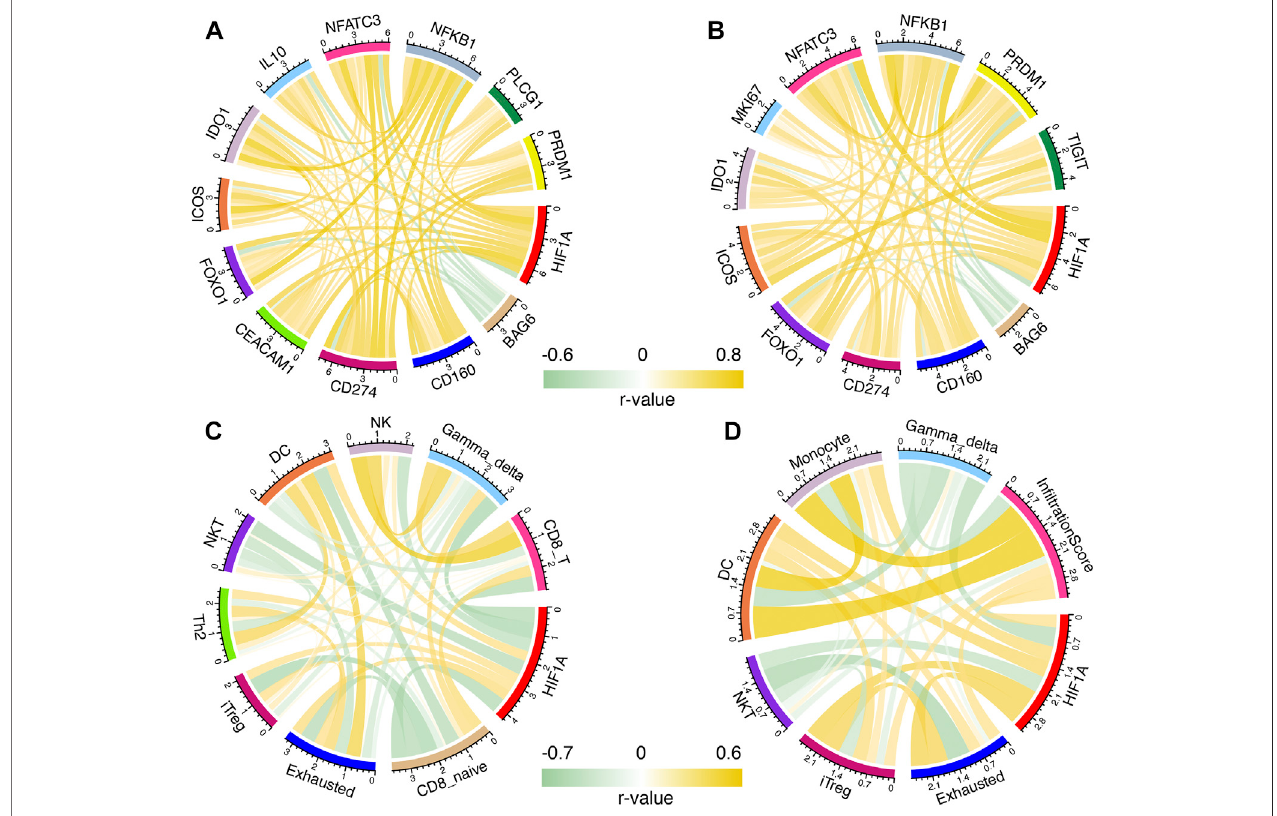
FIGURE4| CorrelationofHIF1AandT-cellexhaustion-relatedgenesinprimary (A) andrecurrent (B) gliomas;correlationofHIF1Aandabundanceofimmunecells in primary (C) and recurrent (D) gliomas.